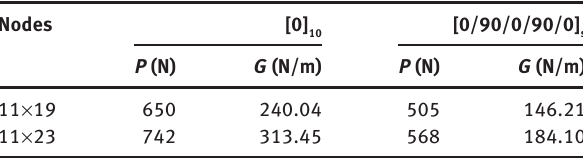
and [0 ° /90 ° /0 ° /90 ° /0 ° ] 10